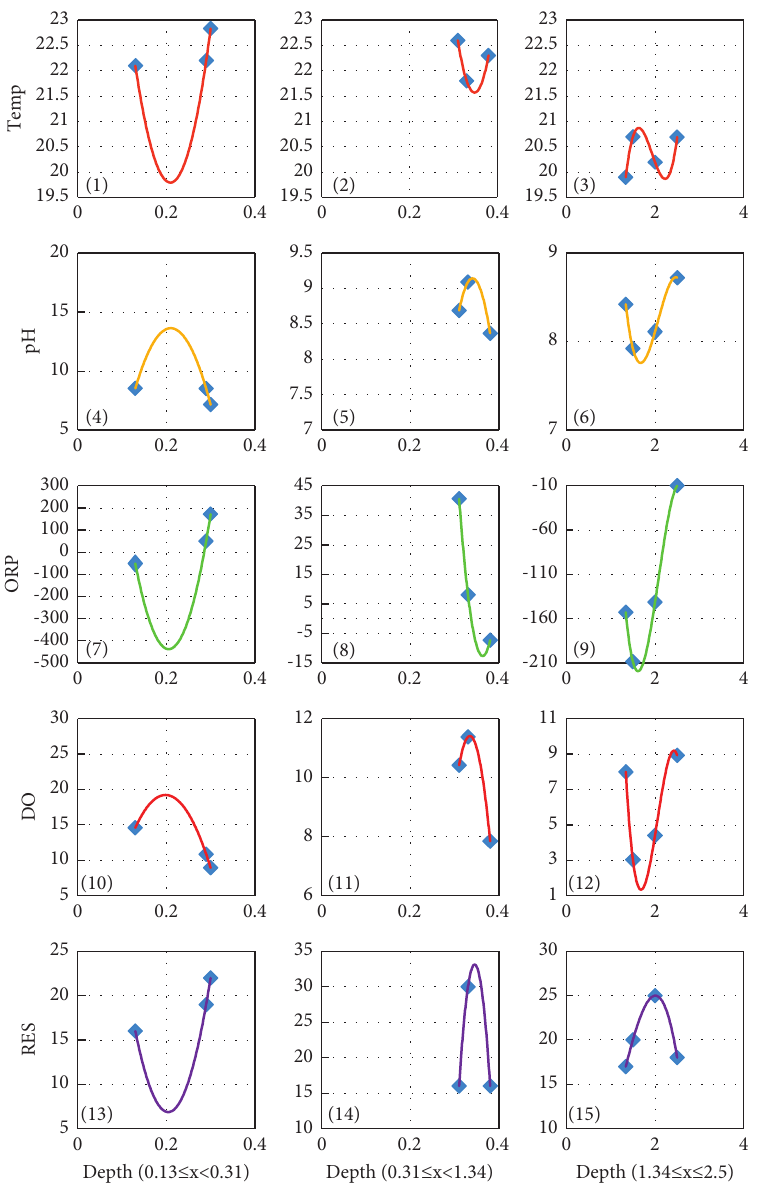
Figure 8: Estimation of the regressions of Temp, pH, ORP, DO, and RES in Lake Manzala,